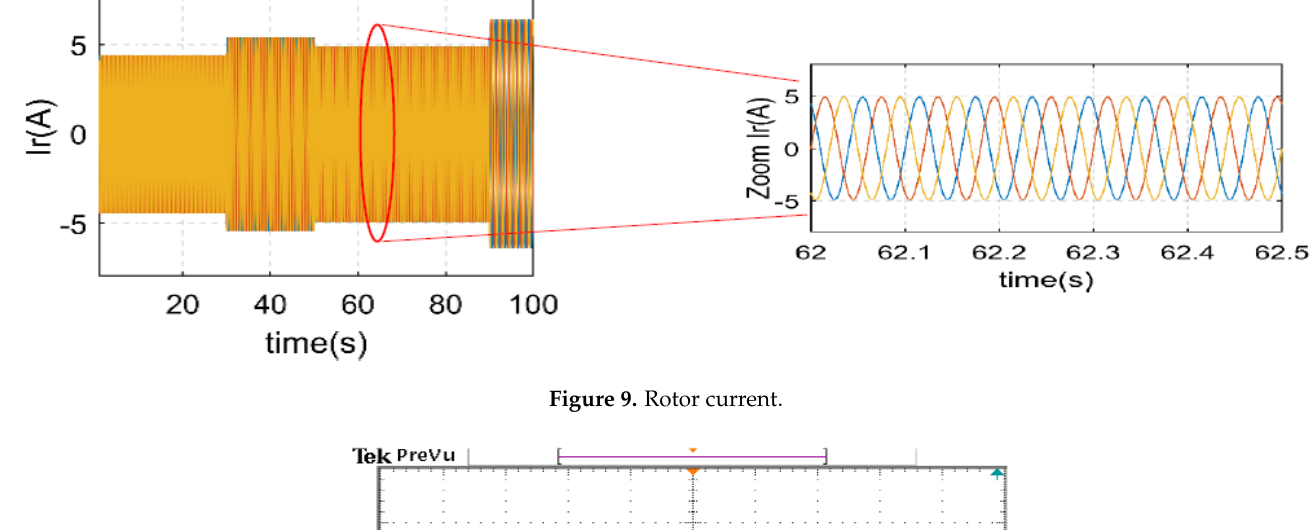
Figure 9. Rotor current.